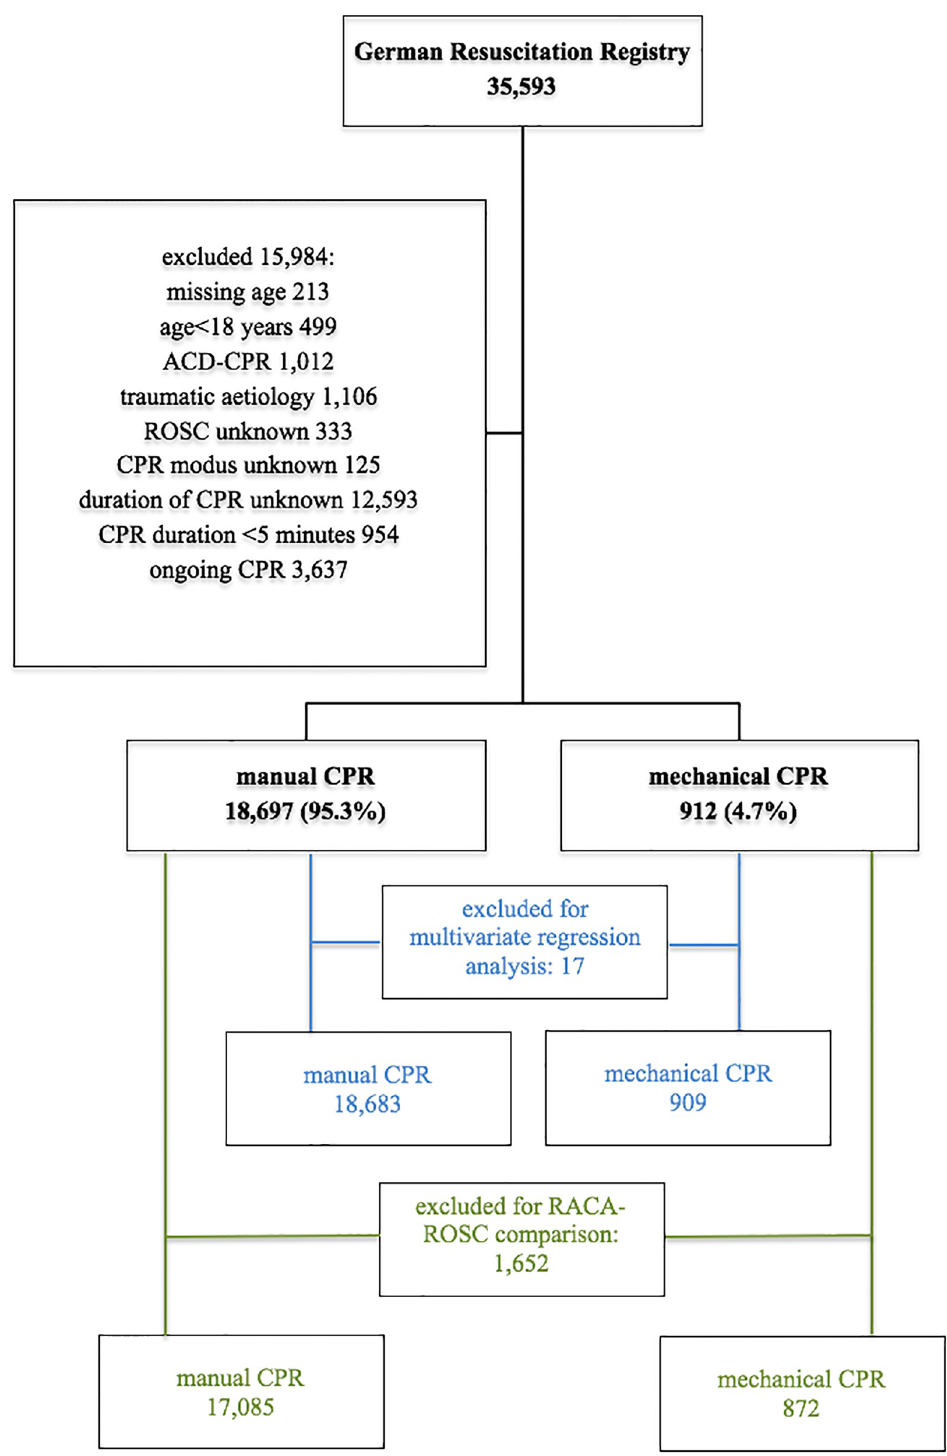
Fig 1. Enrollment. Enrolled: Preclinical setting from 01/01/2007 to 12/31/2014. Excluded cases: multiple entries are feasible. CPR = cardiopulmonary resuscitation; ACD = active compression and decompression; ROSC = return of spontaneous